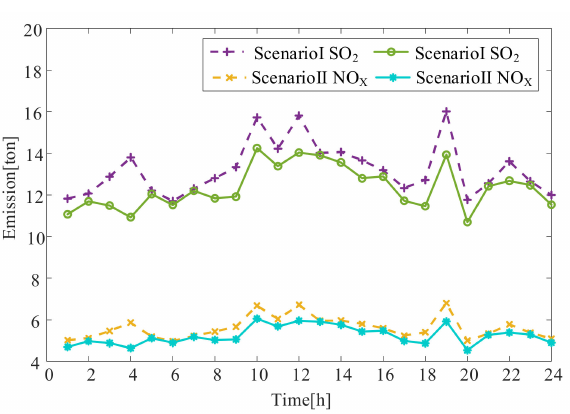
Figure 15. The emission of CO 2 .